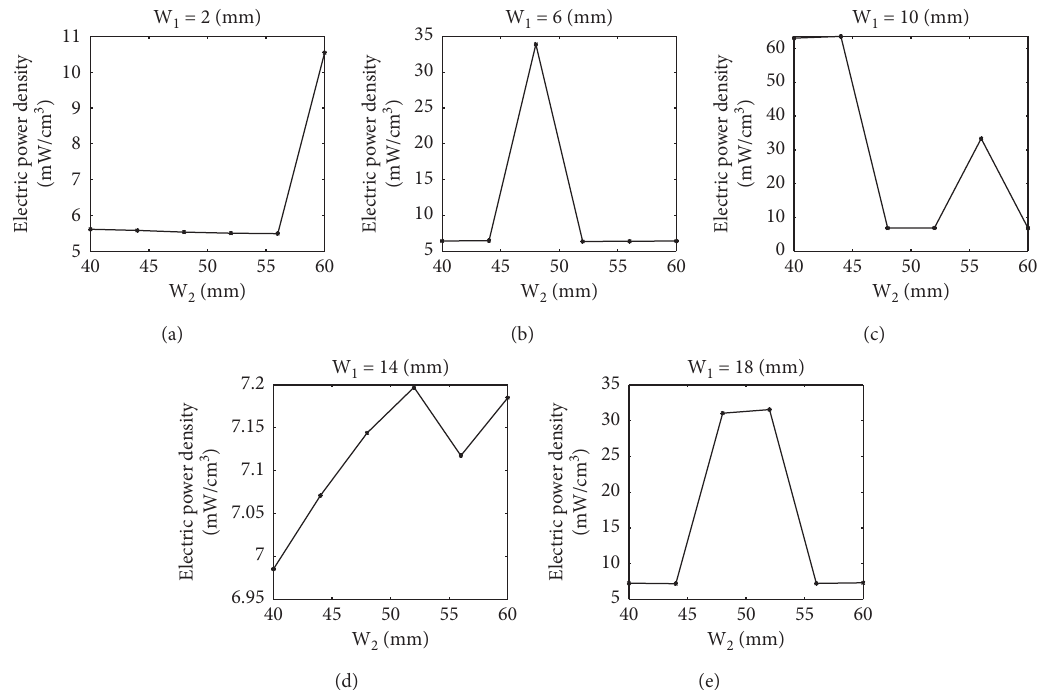
Figure 11: The maximum electrical power density of 30 various geometries of the two-piece trapezoidal composite piezoelectric bimorph beam (first design) in a closed circuit with the optimal resistor load. The length of the beam L is 60 mm, the thickness of T piezo is 0.3mm, and the thickness of the brass layer T s is 0.05mm.